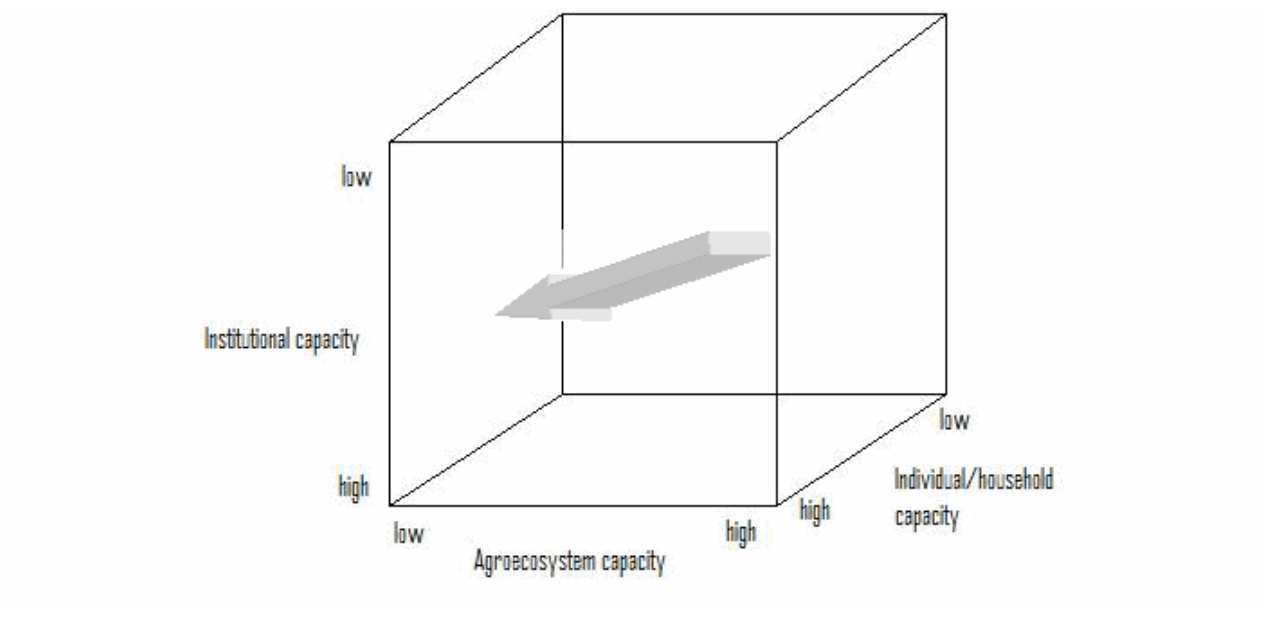
Fig. 4. Trajectory through vulnerability space for Sekhukhune District based on agroecosystem capacity, individual/household capacity, and institutional capacity to cope with stresses (Adapted from Fraser